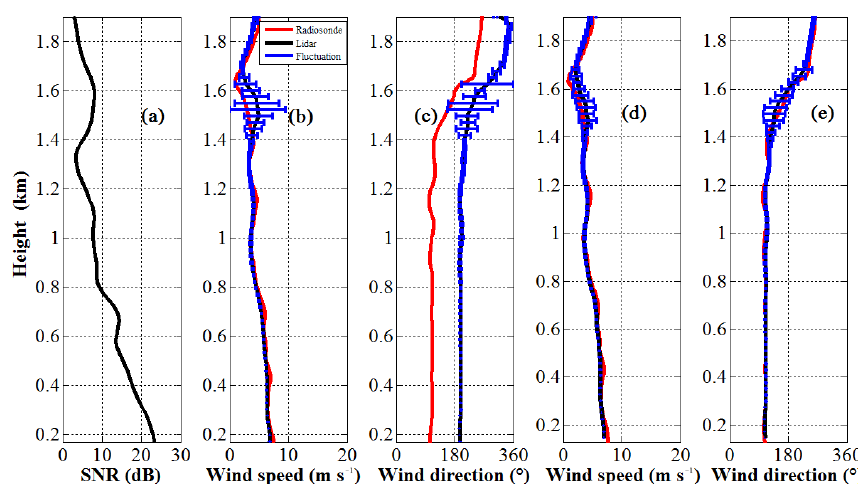
Figure 5. Anchored observation: (a) SNR profile, (b, d) wind speed, and (c, e) wind direction measured by CDL (black line) before and after attitude correction, respectively. The simultaneous radiosonde data is shown as a red line. The blue bars represent the sampling fluctuations from 15:52 to 16:02LT on 9 May 2014.